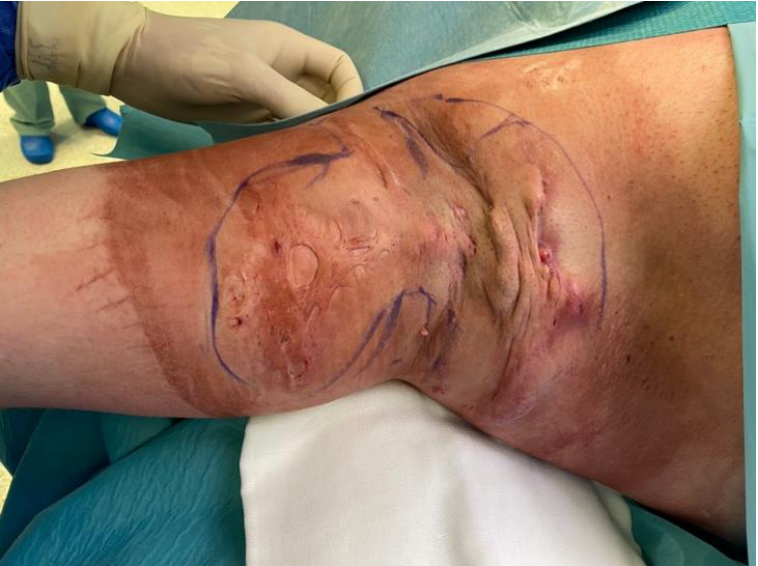
Figure 2. Presentation of second patient — extensive HS of right armpit, before operation. Legend: HS — Hidradenitis Suppurativa.